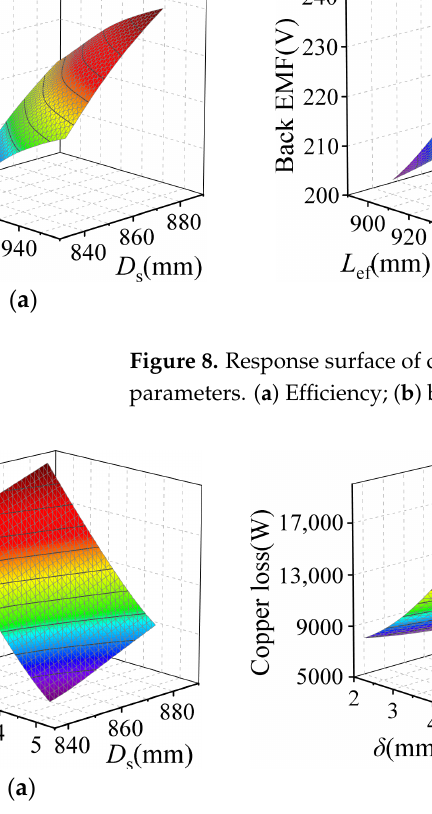
( c ) Figure 7. Response surface of pole arc coefficient and PM thickness to electromagnetic performance parameters. ( a ) Core loss; ( b ) thermal load; ( c ) copper loss. The effect of the core length and stator outer diameter on the efficiency, no ‐ load back EMF and core loss are shown in Figure 8. In Figure 8a, the efficiency increases with the increasing core length and stator outer diameter, and the stator outer diameter has a greater effect on the efficiency than the core length. In Figure 8b, the no ‐ load back EMF is also greatly affected by the core length and the stator outer diameter. The no ‐ load back EMF increases significantly with the increasing core length and stator outer diameter. Fig ‐ ure 8c shows the influence of the core length and stator outer diameter on the core loss. With the increase in the stator outer diameter, core loss first increases and then decreases; this is because the stator outer diameter is too large or too small, which leads to the satu ‐ ration of the iron core, and a larger field strength is required to generate the same amount of magnetic induction, leading to increased core loss. In addition, the core loss also in ‐ creases with the increasing core length. Figure 9 shows the effect of the air gap length and stator outer diameter on the no ‐ load back EMF, copper loss and thermal load. In Figure 9a, the air gap length has a great